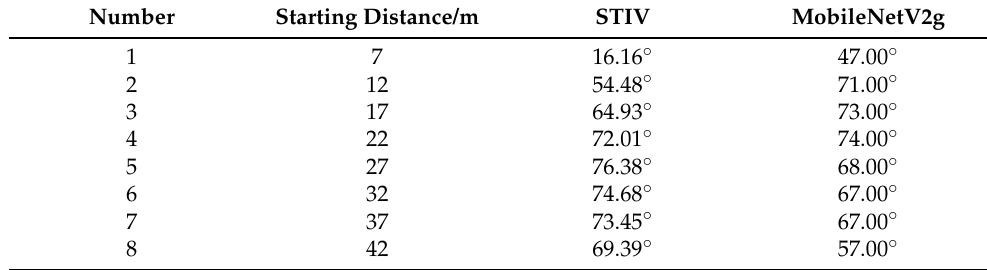
Table 6. Test results of MOT.